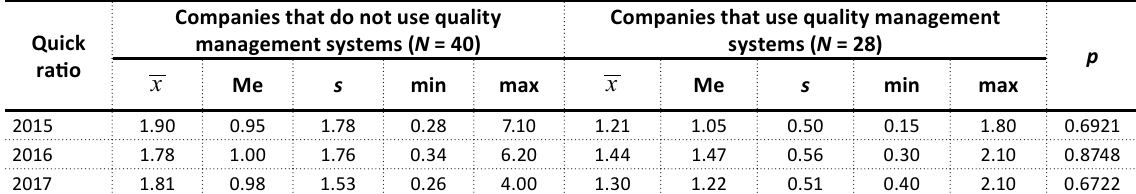
Table 5. Average results for the quick ratio in the enterprises